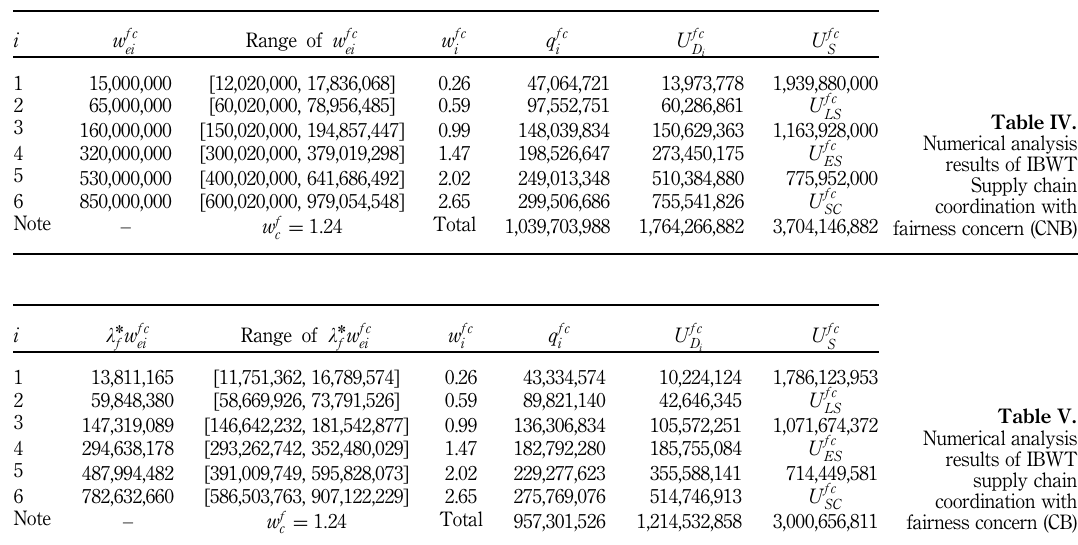
Table V. Numerical analysis results of IBWT supply chain coordination with fairness concern (CB)